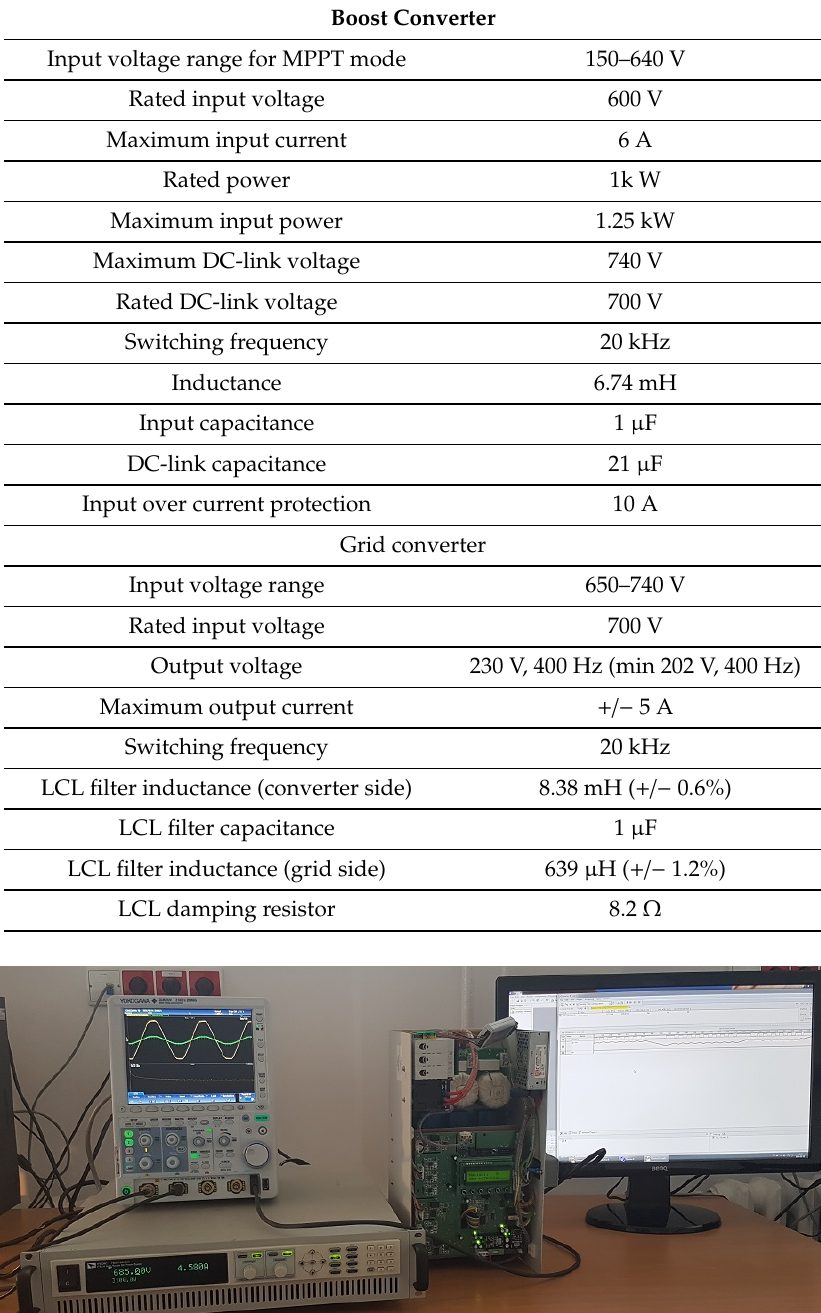
Table 1. Parameters of boost converter and grid converter.